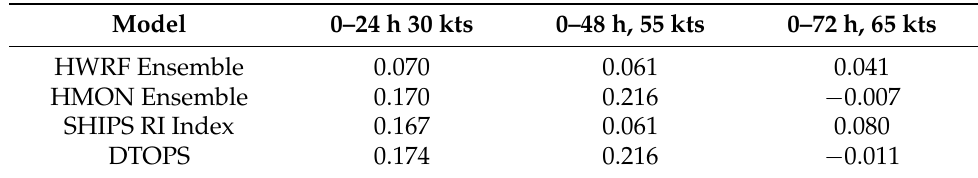
Table 4. Brier Skill Score (BSS) for the probability of TC maximum wind speed changes for varied time